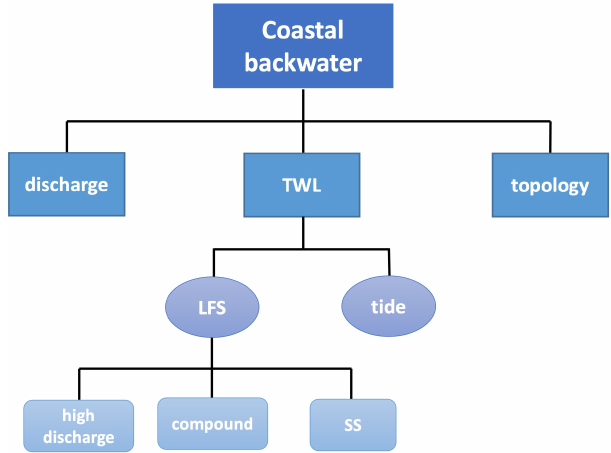
Figure 3. Decomposition of the drivers of backwater effects.